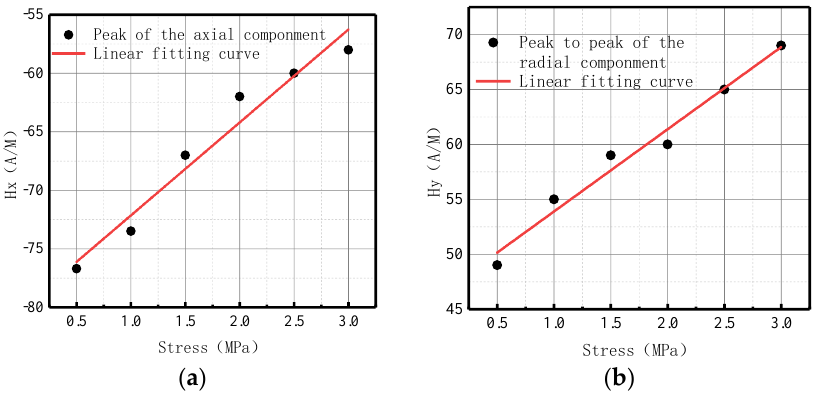
Figure 26. Peak value variations with internal pressure. ( a ) Peak values of the axial component; ( b ) peak-to-peak values of the radial component.